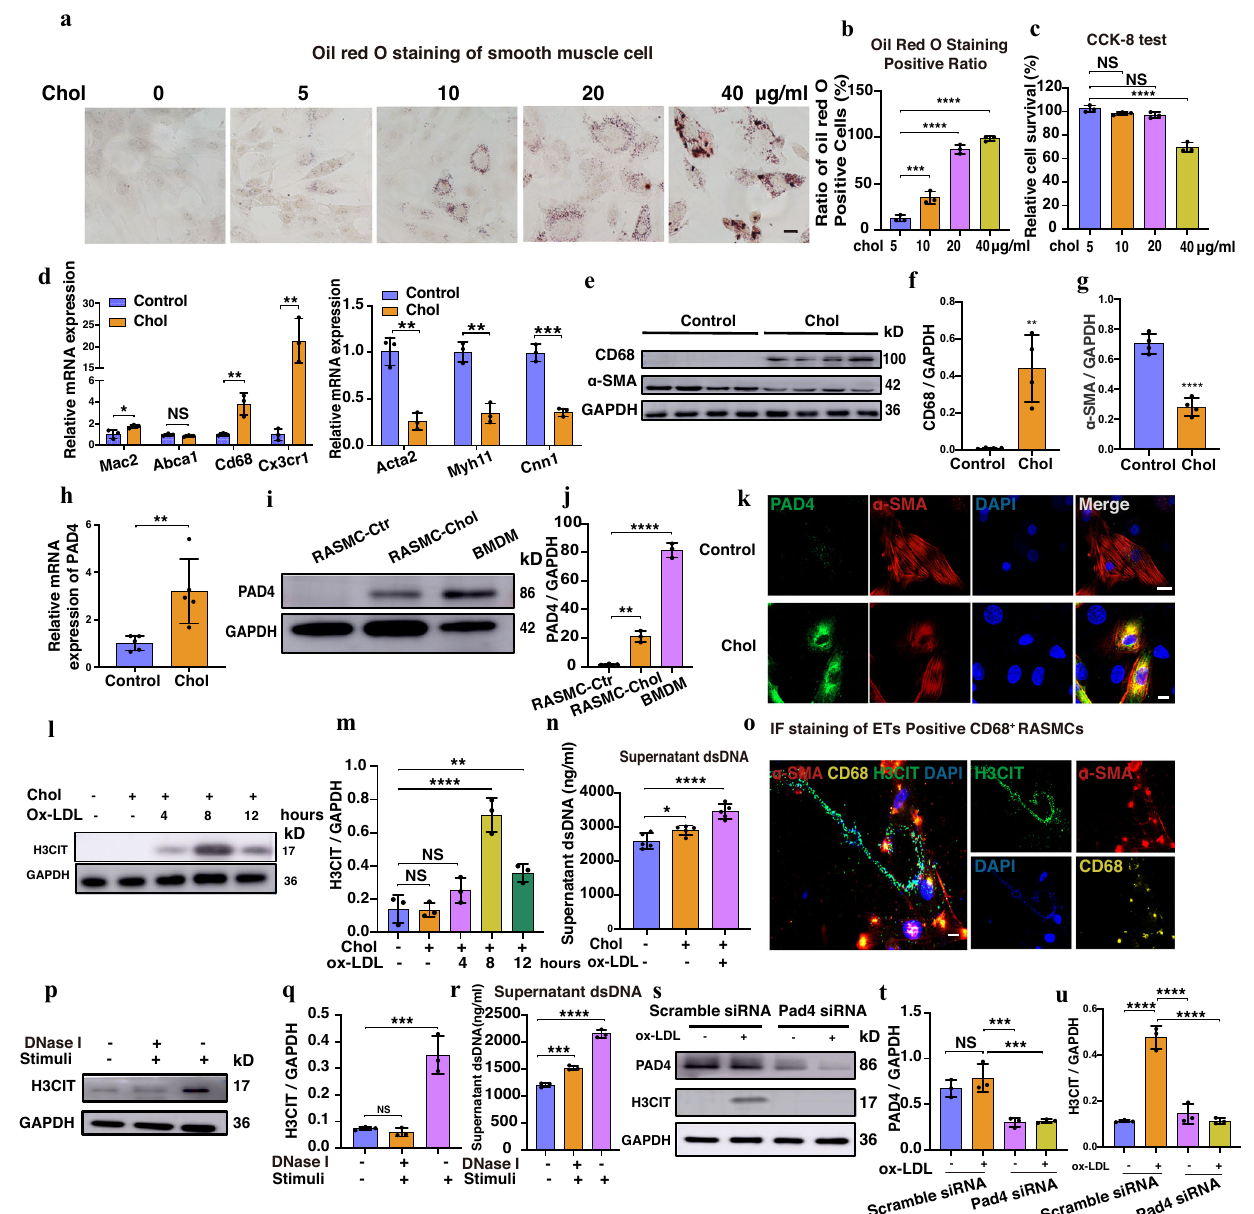
Fig. 2 | Low-density lipoprotein induced CD68 + VSMCs generated ETs in Vitro. a Oil red O staining in VSMCs. Scale bar=50 μ m. b Quantitation of a ( n =3